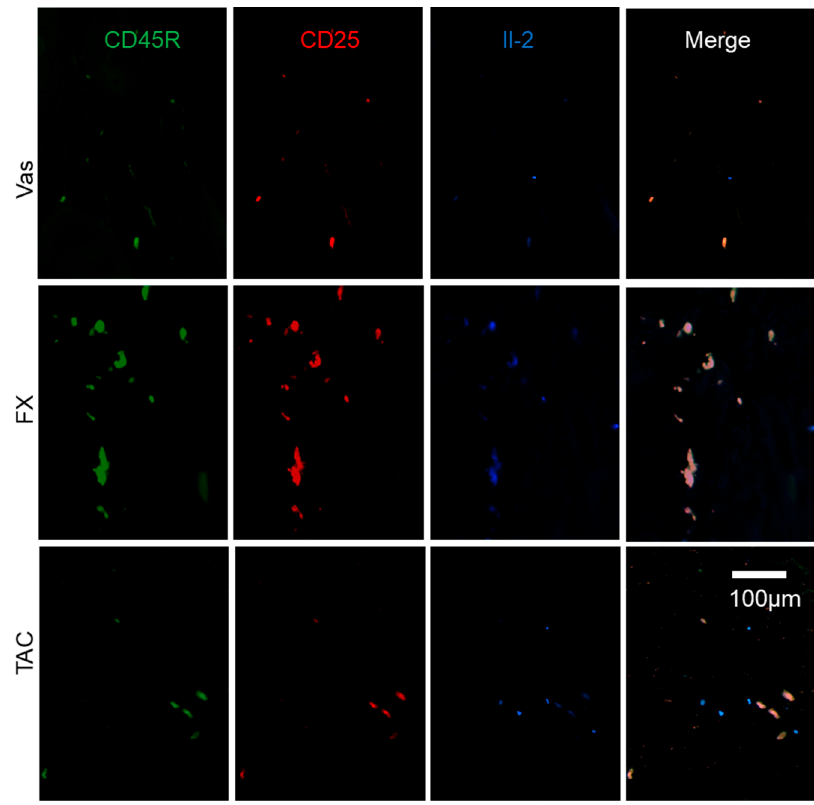
Figure 6. The characterization of Il-2 producers regulated by FX and TAC. FX stimulated Il-2 production in CD45R + CD25 + ILCregs. Some Il-2 + CD45R + CD25 + ILCregs were observed in TAC treated skin and others were CD45R - CD25 - cells. The panel is focused on the dermis.